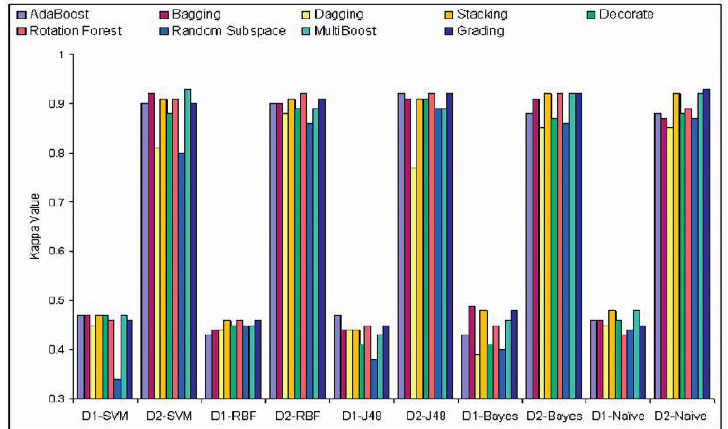
Figure 6. Kappa Statistics value of nine ensemble learning method vs. cascaded k - means C ensembles with five base classifiers for PIDD (D1: unprocessed data, D2: processed data).